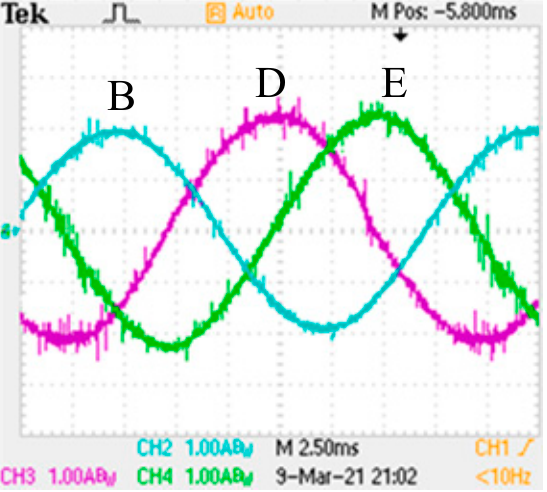
Figure 15. Waveform diagram of the lack of phase A and C current experiment.